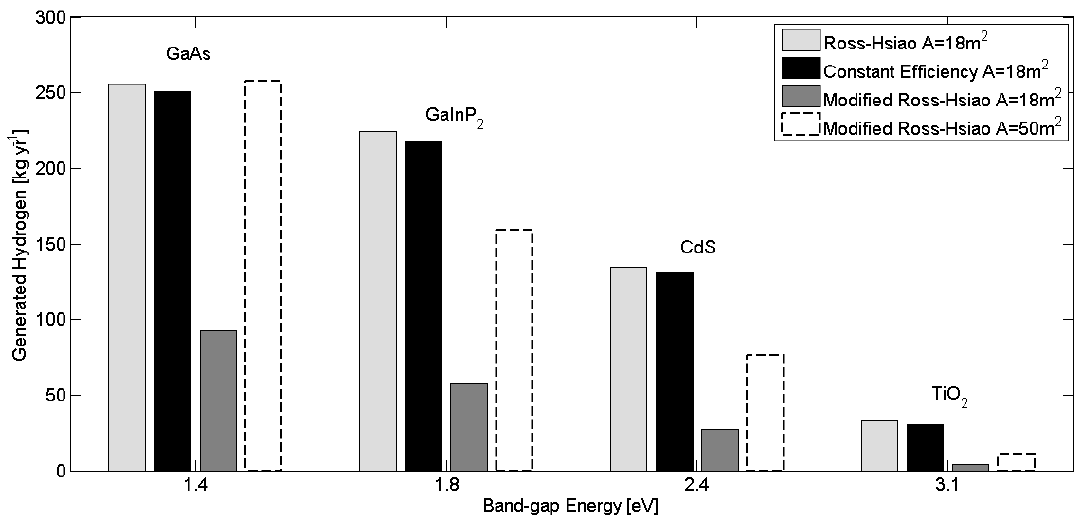
Figure 7. Annual generated hydrogen can be seen as a function of band-gap energies in the cases of analysed model approximation.